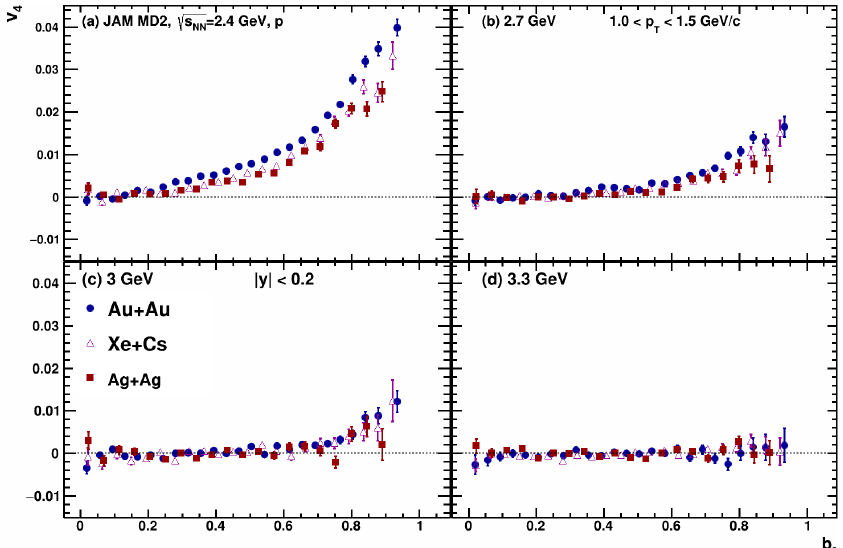
Figure 26. Scaled impact parameter b 0 dependence of quadrangular flow v 4 of protons in the transverse momentum interval 1.0 < p T < 1.5 GeV/c at mid-rapidity | y cm | < 0.2 from Au + Au (closed circles), Xe + Cs (open triangles), Ag + Ag (closed boxes) collisions at energies (panel ( a )), 2.7 GeV (panel ( b )), 3 GeV (panel ( c )) and 3.3 GeV (panel ( d )). The results for JAM model with hard momentum dependent mean-field MD2 ( K 0 = 380 MeV) EOS.